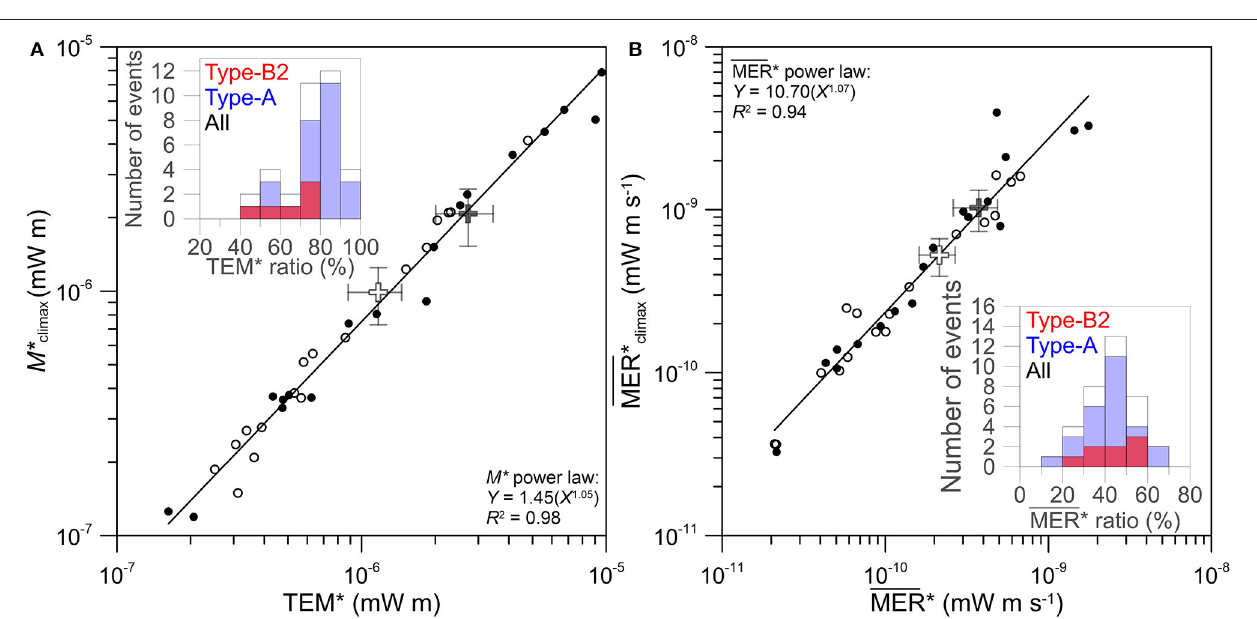
FIGURE 4 | Radar-derived proxy for the total mass of tephra (TEM*) emitted by each detected paroxysm of Etna between January 2011 and December 2015, showing periods of grouped eruptive episodes. Gray areas indicate the periods of power outages.